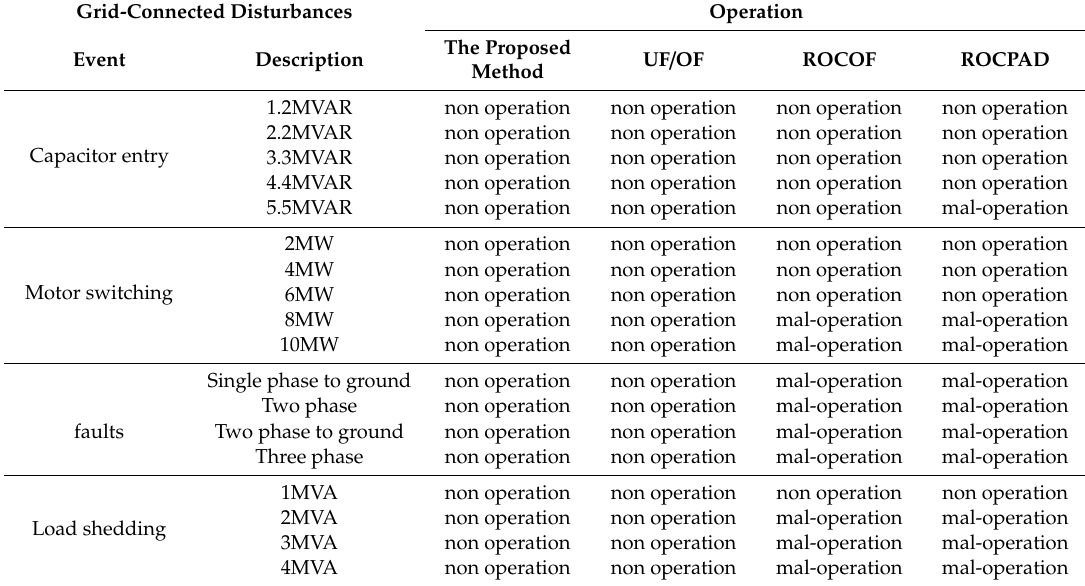
Table 2. Result of operation of the proposed method and classic methods in the non-islanding